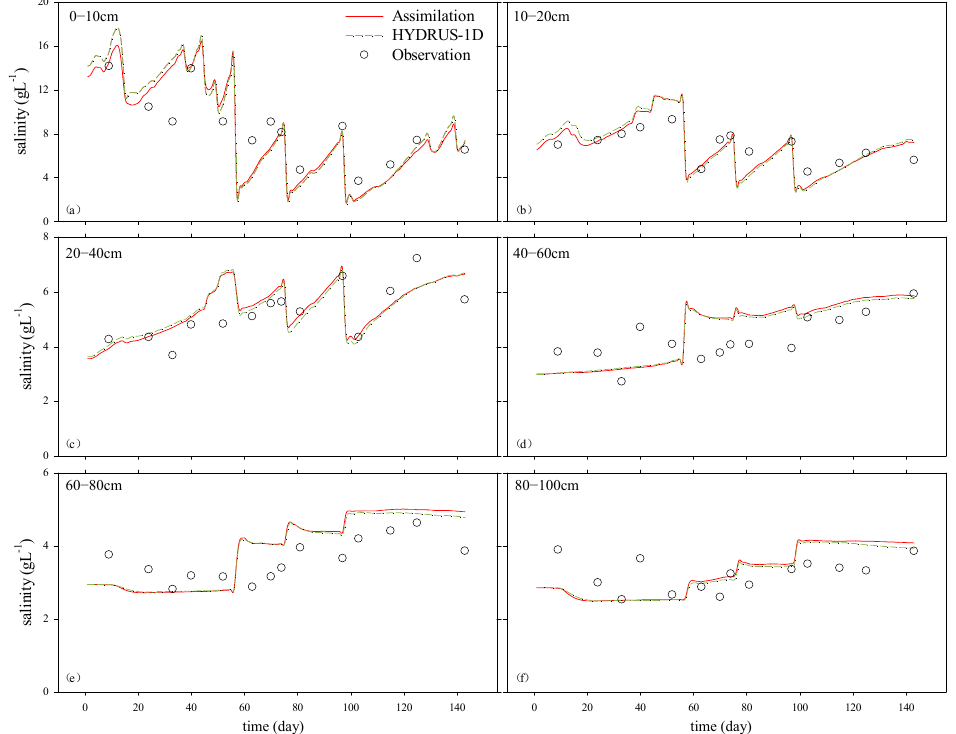
Figure 4. Simulated salinity at different depths with assimilation of only the soil moisture. (Green dashed lines represent the simulated results from Ren et al. [34] obtained using HYDRUS-1D; red solid lines represent the assimilation results).